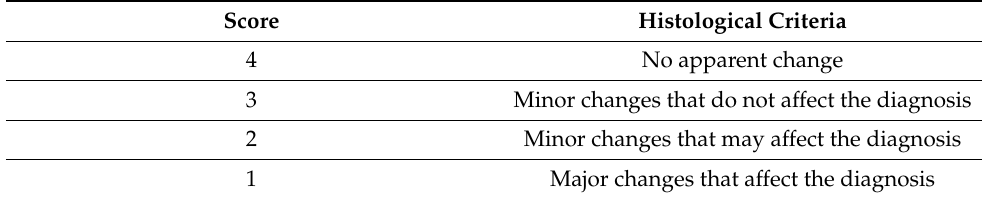
Figure 3. Photomicrographs of a hematoxylin–eosin-stained section of tissues fixed in different media at different time points (5×). Table 1. Numerical scale for microscopic tissue structures assessment.